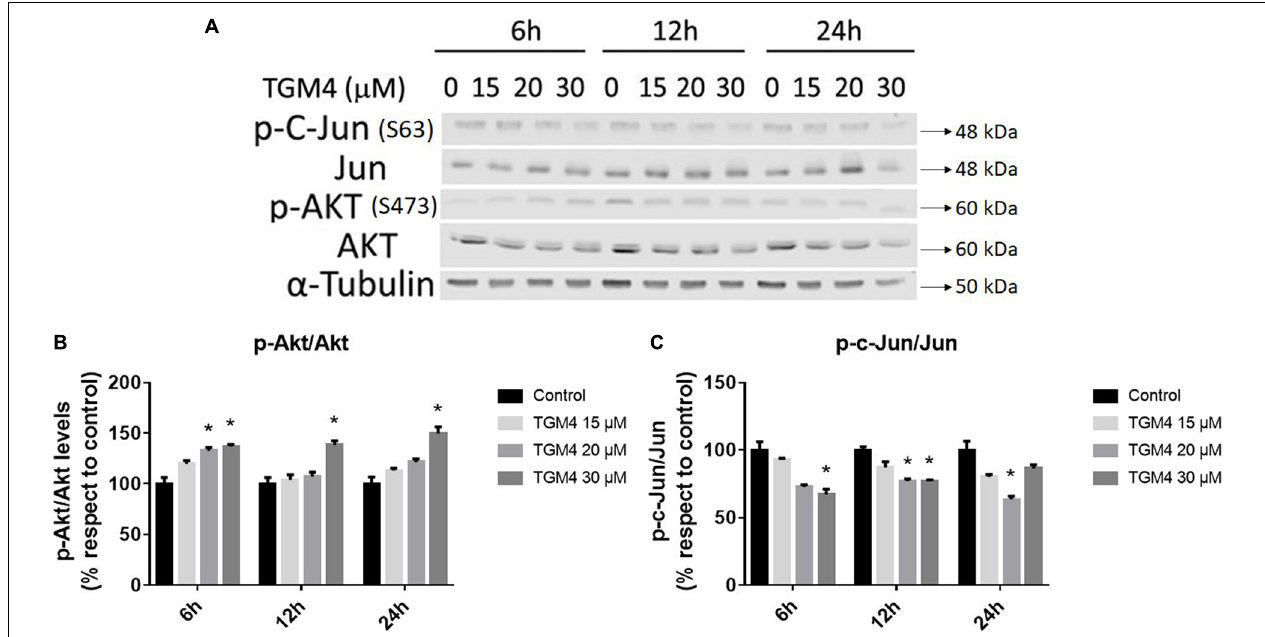
FIGURE 7 | Protein analysis of PANC-1 cells treated with TGM4 at different doses and times. Representative immunoblots (A) and quantification (B,C) of p-AKT(S473)/AKT ratio and p-c-Jun(S63)/Jun ratio. Data were normalized by α -tubulin. Each value represents the mean ± SEM ( n = 3) expressed as a percentage with respect to control (100%). The significance was determined by a t -test (* p < 0.05).